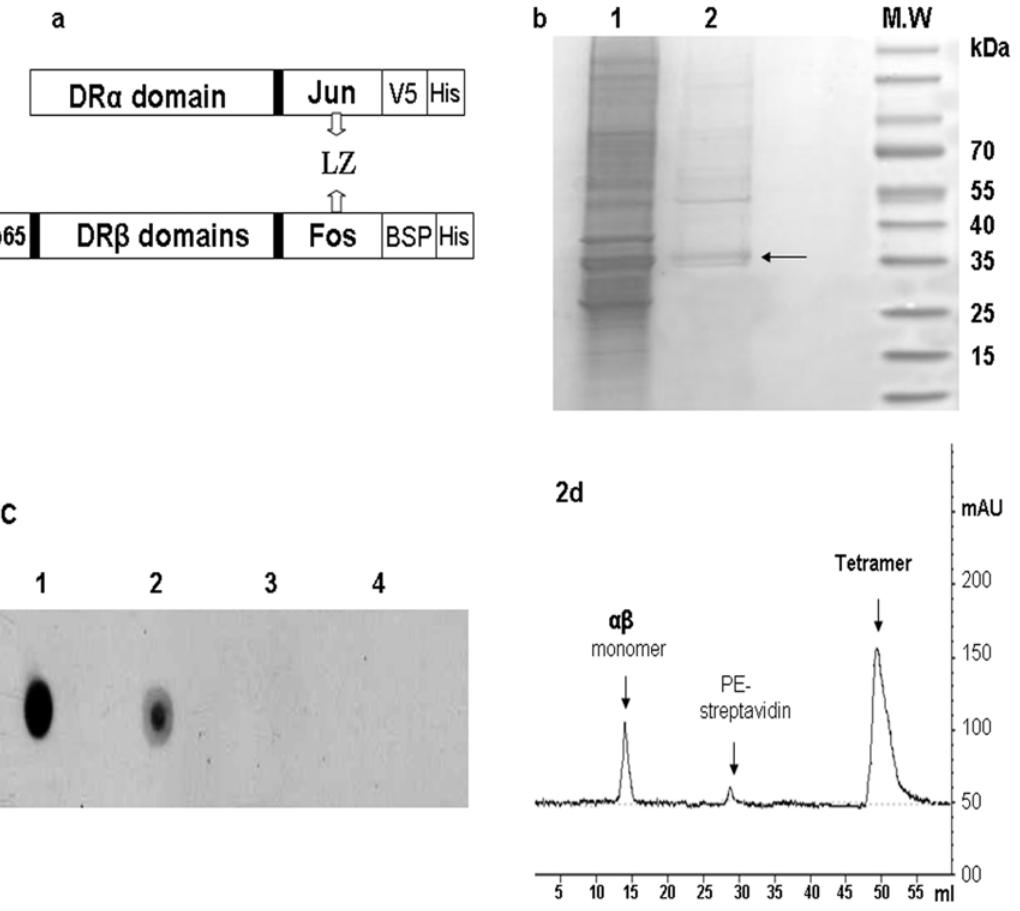
Figure 2. Production and characterization of soluble Mamu-DR ab monomer and Mamu-DR*W201/P65 tetramer. (a) Schematic presentation (cartoon) of the covalent peptide approach for developing class II MHC/peptide complex constructs. The epitope-coding sequence is linked to the 5 9 Mamu-DR b cDNA; Jun and Fos-BSP are introduced by linking the extracellular domains of DR- a and - b chain, respectively. The recombinant Mamu-DR ab monomer is stabilized by leucine zipper (LZ) formed through Jun-Fos interaction. (b) Protein samples after 1 st round (lane 1) and second round (lane 2) purifications were separated in the SDS-PAGE gel in reduction conditions and stained. Lane 1, the (His) 6 tagged recombinant protein purified from Ni-NTA agarose; lane 2, the biotinylated Mamu-DR recombinants purified further through an avidin column after biotinylation. The arrow indicates two closely-separated protein bands in lane 2 ( , 34, 36 kD) that correspond to predicted molecular weights of Mamu-DR a and b recombinants, respectively. (c) Dot blot assay indicates that anti-HLA-DR antibody (L243) bound to the soluble recombinant Mamu-DR ab monomer purified by Ni-NTA affinity column (loading 1) and further by an avidin column (loading 2), but not to the denatured Mamu- DR ab sample (loadings 3). The supernatant of non-transfected S2 cells served as a negative control (loading 4). (d) FPLC graph shows that the unbound Mamu-DR ab molecules and free fluorescents were washed out, and the assembled Mamu-DR*W201-P65 tetramer was collected and marked as